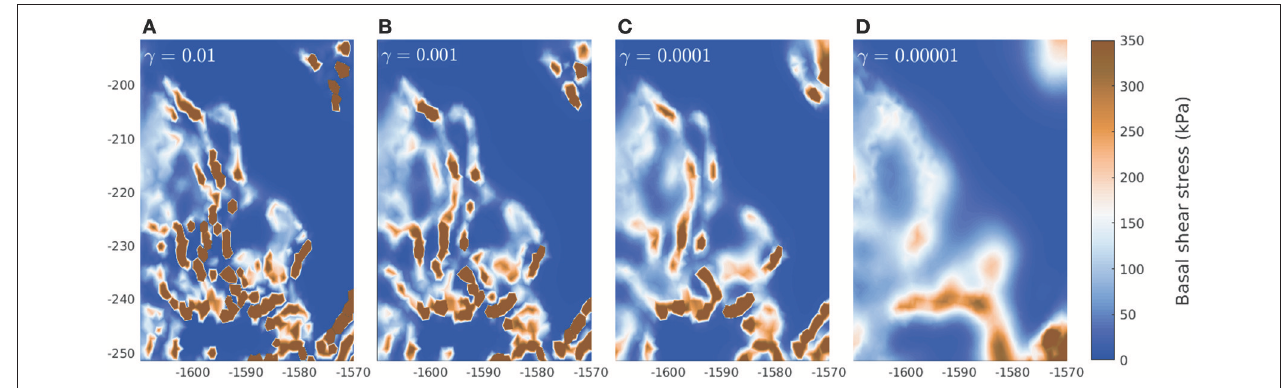
FIGURE 7 | The basal stress field from inversion of surface data over a 40 × 60km 2 area of the domain, corresponding to the area by the grounding line over which Sergienko and Hindmarsh (2013) observed riblike patterns of very high basal shear stress. (A–D) are results with four different amounts of regularization applied to the inversion (the value of γ in Equation 11 for each is given). The amount of regularisation increases from A–D